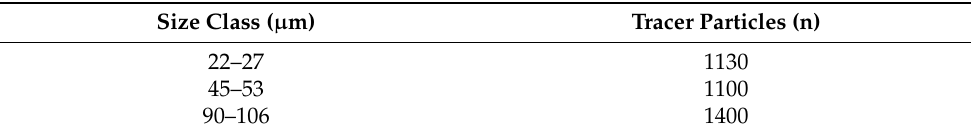
Table 2. Number of added tracer particles for validation of the recovery rates of the